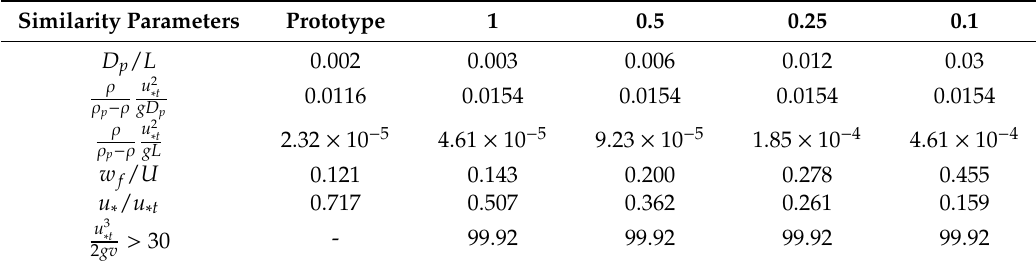
Table 4. Similarity parameters of prototype and scale